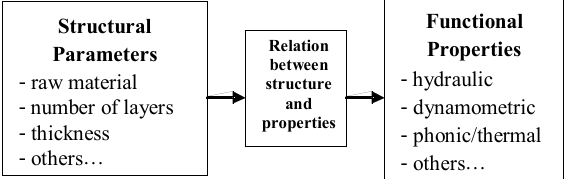
Fig. 1. Modeling the relations between structural parameters and functional properties of nonwovens.